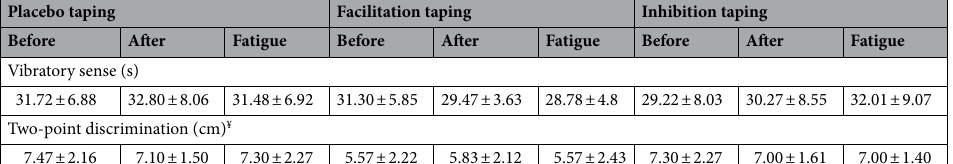
Within-subject (pre-post-post